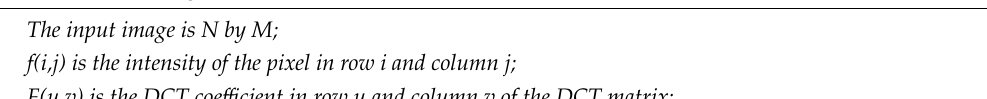
Algorithm 1. DCT